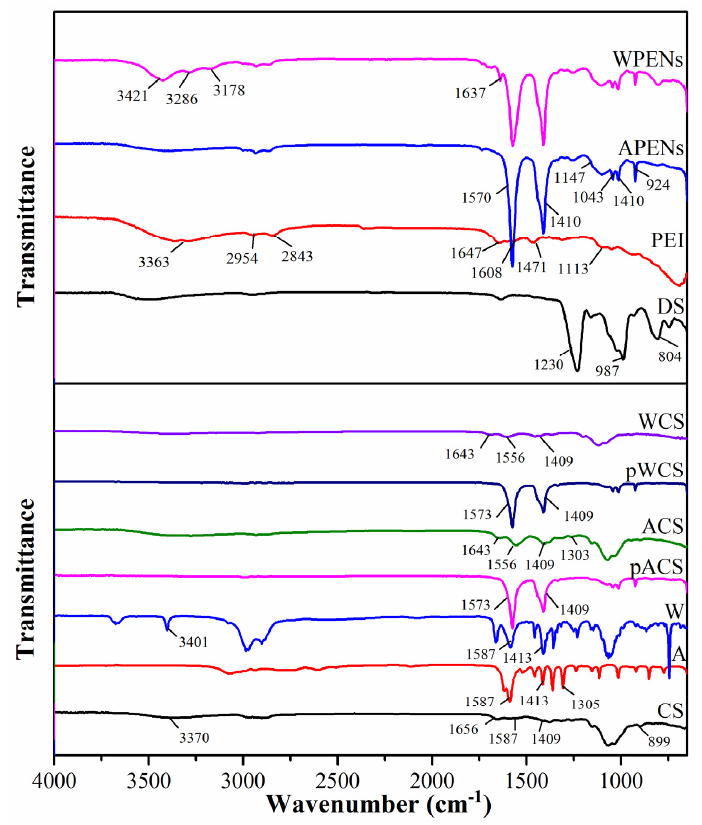
Figure 4. FTIR spectra of neat materials (CS, A, W, DS, PEI) physically (pACS and pWCS) and chemically (ACS, WCS), a mixture of amino acids with CS, and nanostructures (APENs and WPENs).